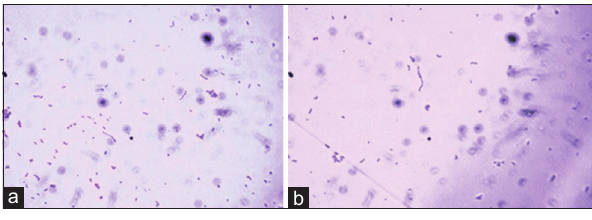
Figure-1: Gram staining of (a) Strain 1 and (b) Strain 2 as Gram-positive cocci; single, diplococci or in chain of 4-10 cells.